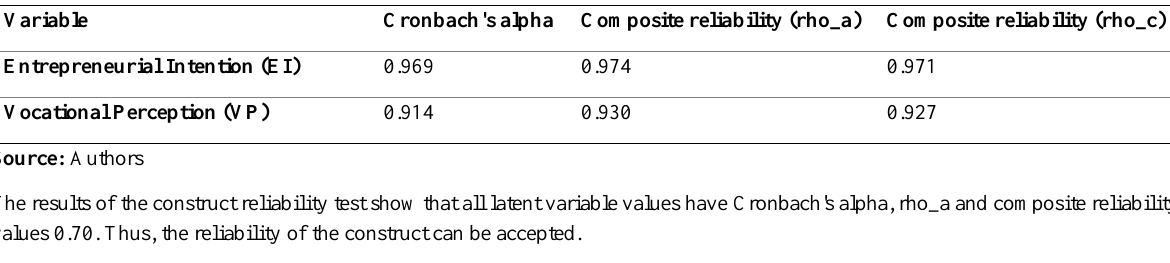
Table 4: Construct Reliability Test